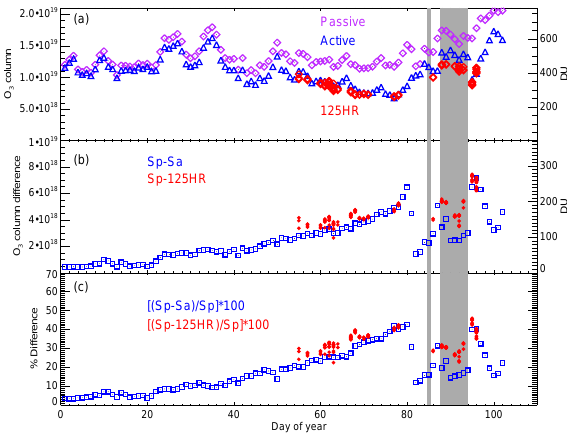
Fig. 8. (a) Passive (purple) and active (blue) SLIMCAT, and the 125HR (red) ozone total columns. (b) The absolute differences be- tween the SLIMCAT passive (Sp) and active (Sa) ozone columns (blue squares) and the differences between the SLIMCAT passive (Sp) ozone and the measured (125HR) total columns (red circles). Panel (c) is similar to panel (b) , but for the percentage differences calculated for the two cases. The gray shading has the same mean- ing as in Fig.